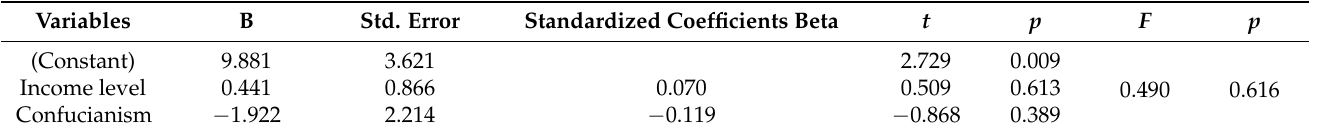
Table 3. Major factors of suicide rates in Confucian and European countries.